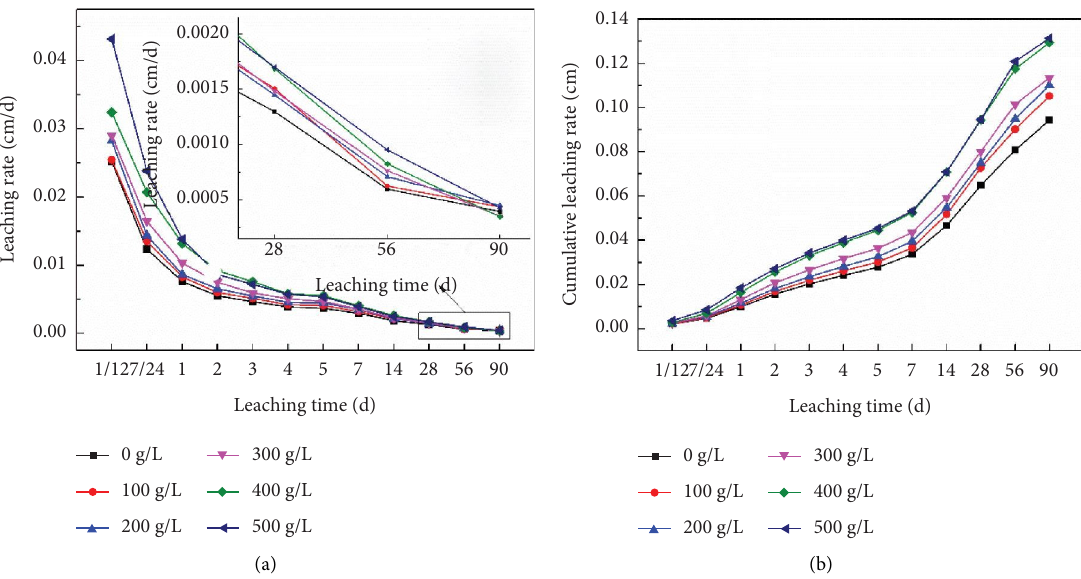
Figure 16: Te leaching curves of Ca 2+ in the SFCM with diferent concentrations of sodium nitrate at a sodium hydroxide content of 5%: (a) LF of Ca 2+ ; (b) CLF of Ca 2+ .